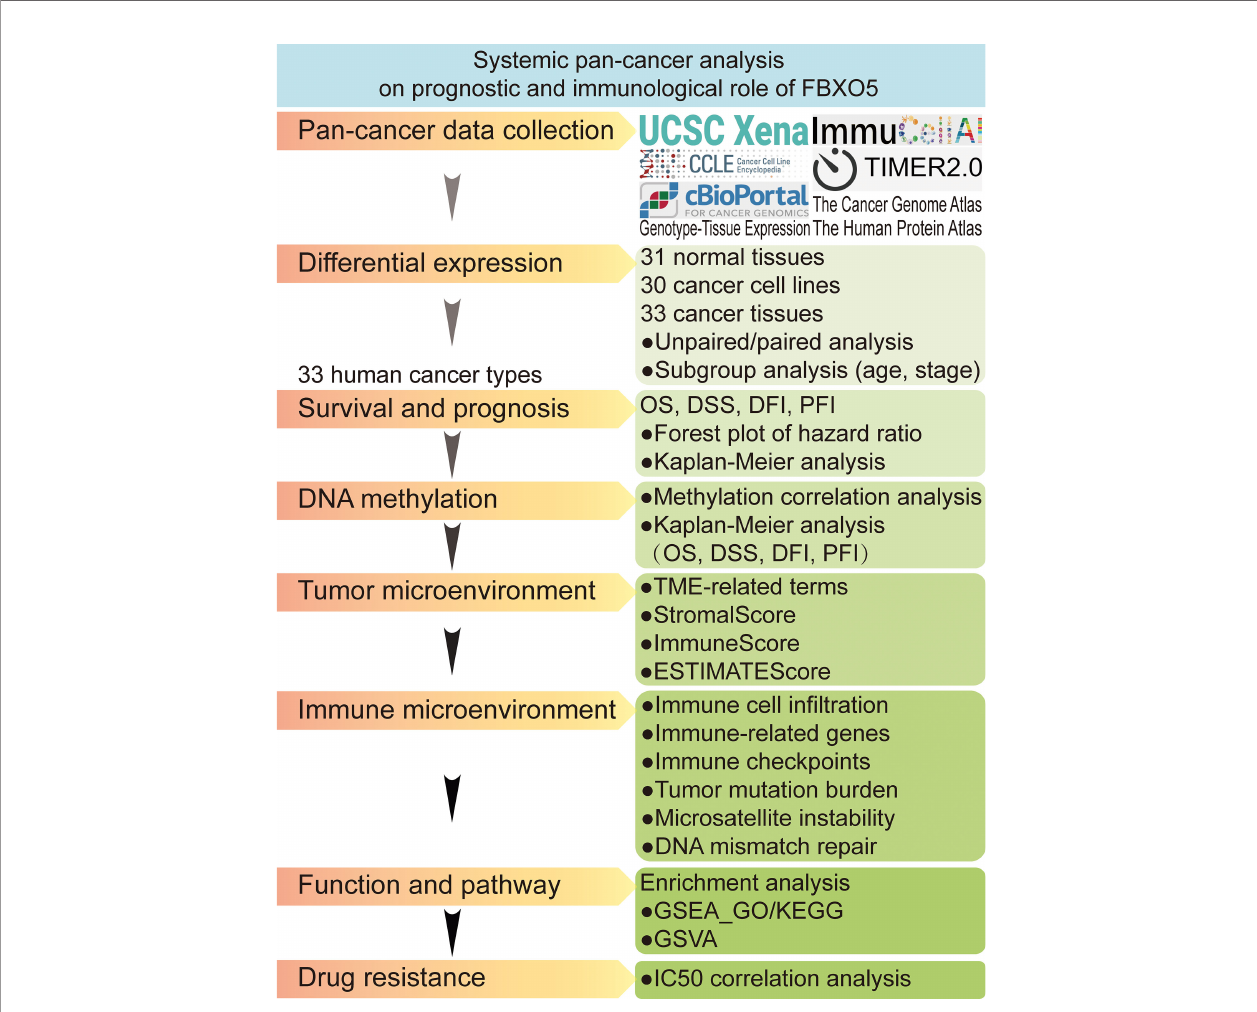
FIGURE 1 | Flow chart of systematic pan-cancer analysis of